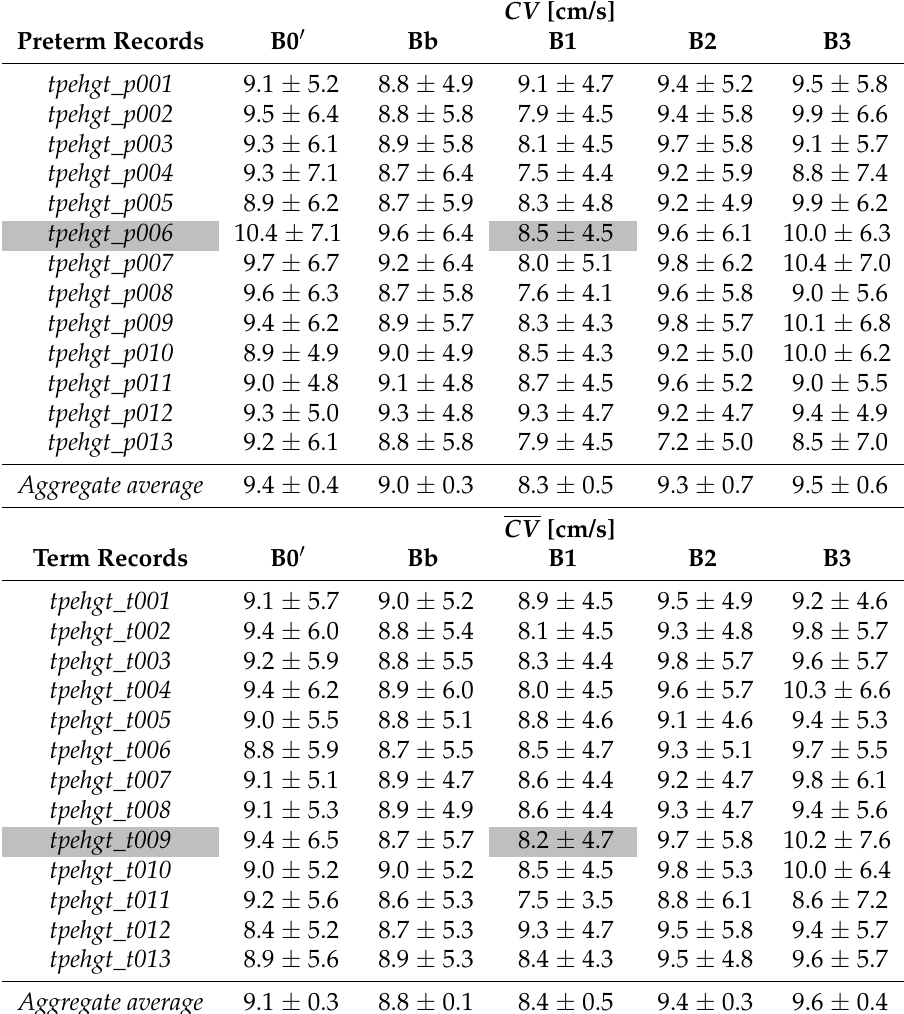
Table A2. Average conduction velocity amplitudes, CV , as estimated over the entire preterm and term EHG records of the TPEHGT DS. For the time courses of the conduction velocity amplitudes, CV , of the gray-shaded records, see Figures A3 and